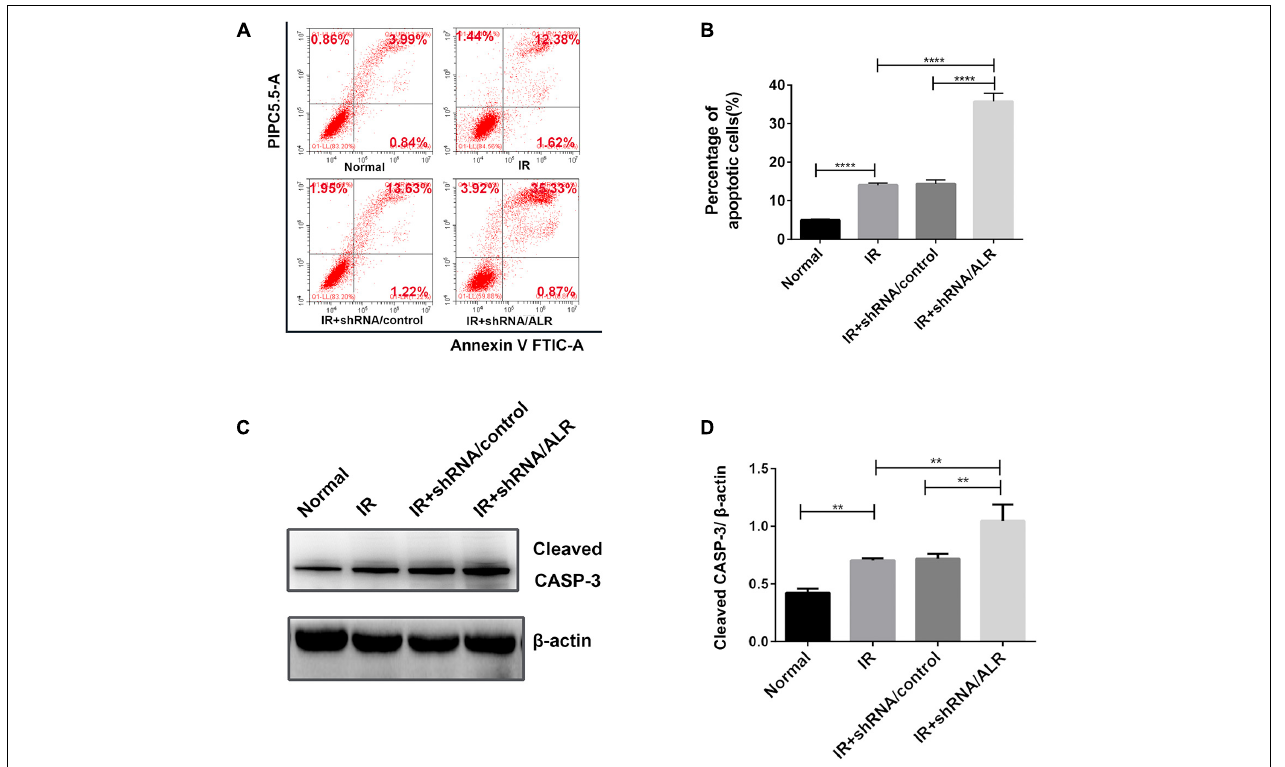
FIGURE 8 | Silencing of augmenter of liver regeneration (ALR)-sensitized HK-2 cells to induced apoptosis. Apoptosis was determined by flow cytometry and activated caspase-3 (CASP-3). (A,B) Representative plot and quantitation analysis of apoptosis measured by flow cytometry. (C,D) Immunoblot analysis and quantification of activated CASP-3. Data represent means ± SD. n = 3. ** p < 0.01, **** p < 0.0001.